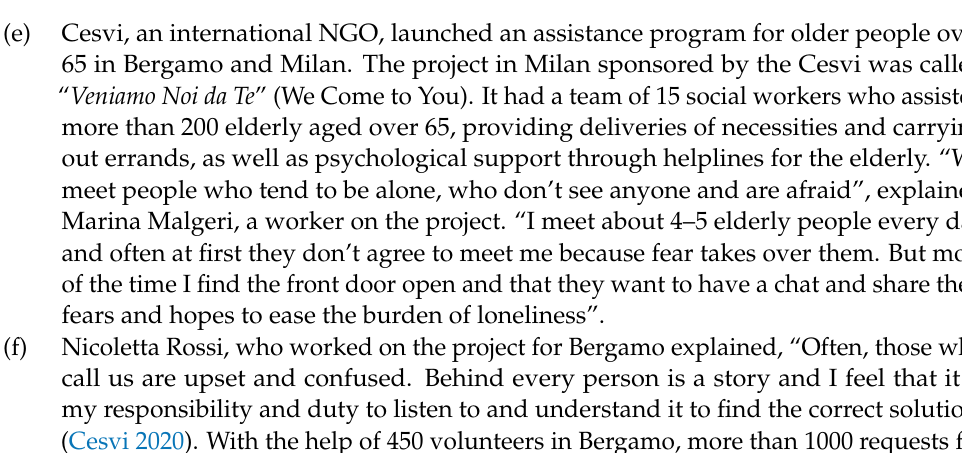
Figure 17. Use of public transportation in Milan under the first